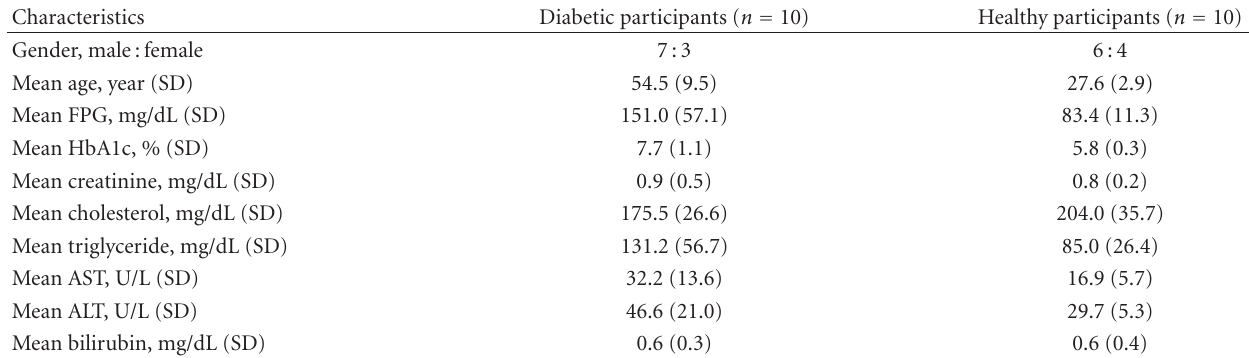
Table 1: Baseline characteristics of the subjects in the study.